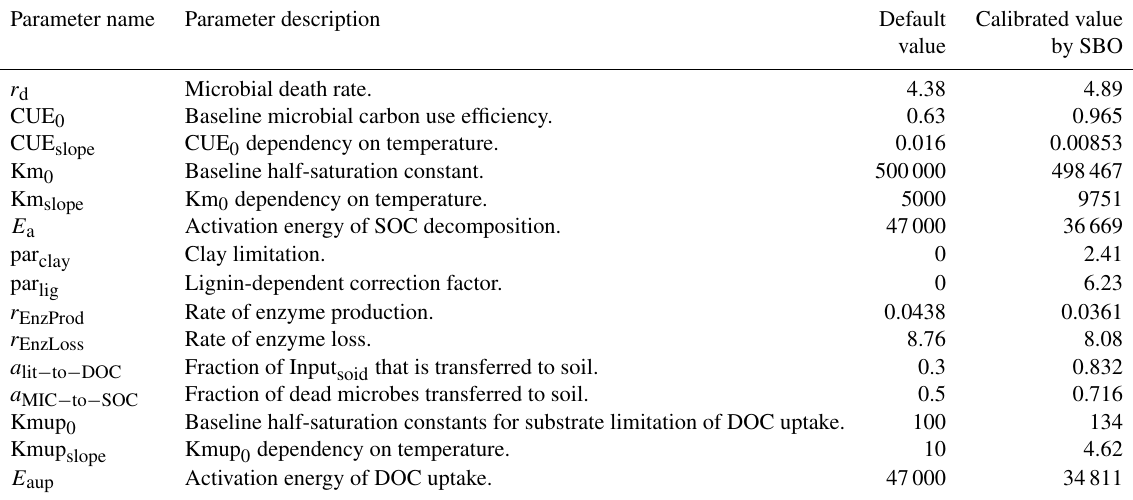
Table 2. Parameter and description of the four-pool microbial